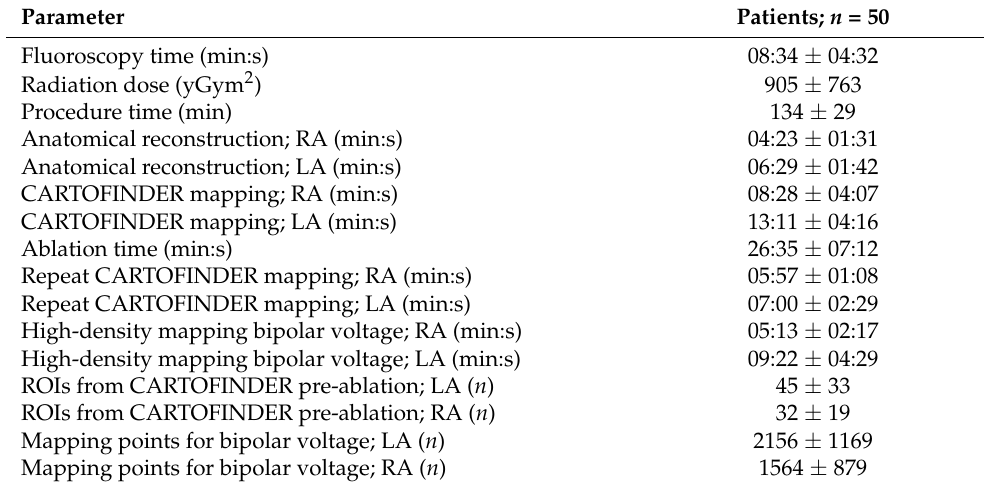
Table 2. Procedural data (RA, right atrium; LA, left